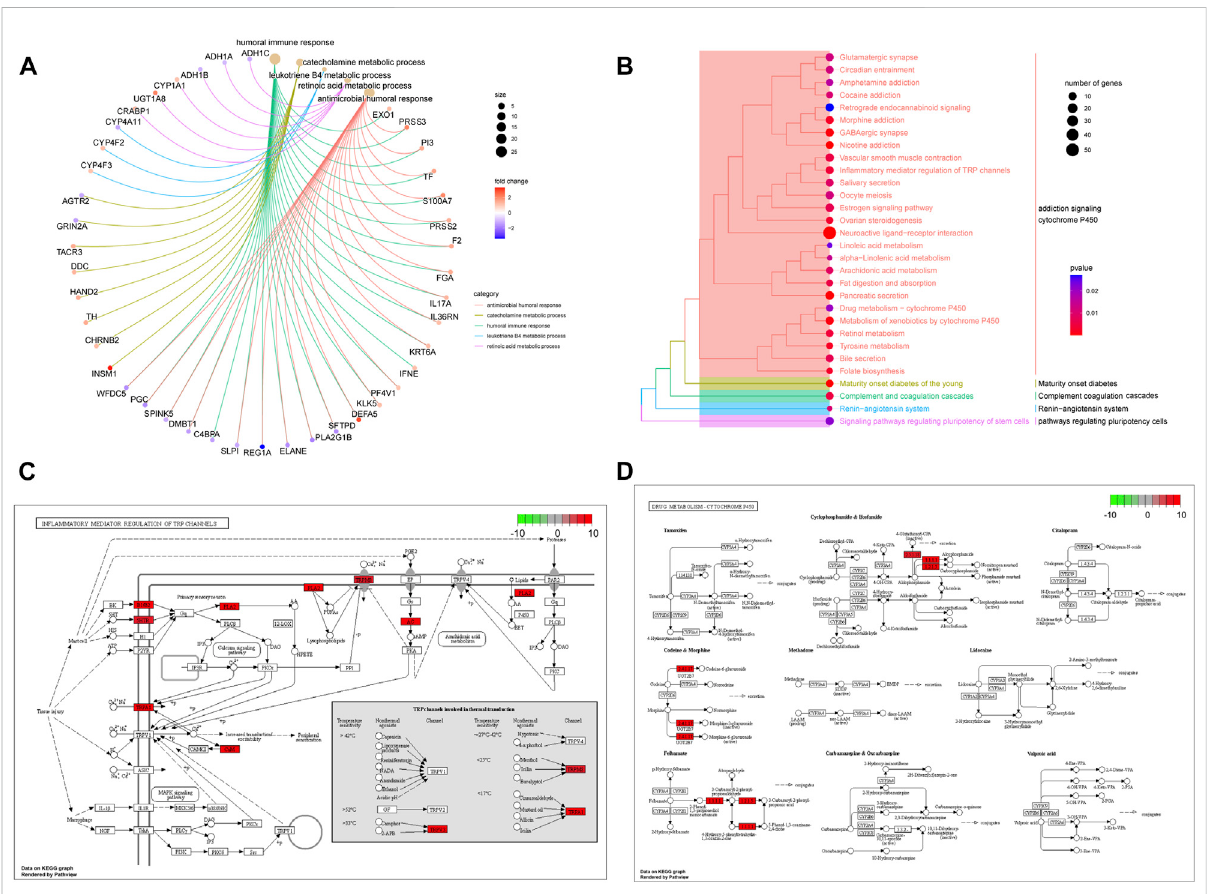
FIGURE 6 Functions and pathways associated with the risk score. (A) GO enrichment analysis of DEGs between high-risk and low-risk groups. (B) KEGG enrichment analysis of DEGs between high-risk and low-risk groups. (C,D) Signal pathway plots of hsa00982 and